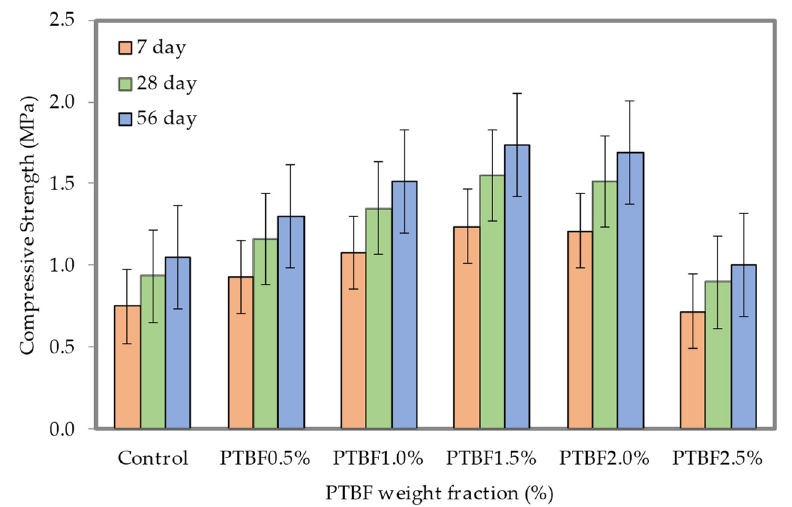
Figure 12. Compressive strength of 500 kg/m 3 density LFC with different weight fractions of PTBF.